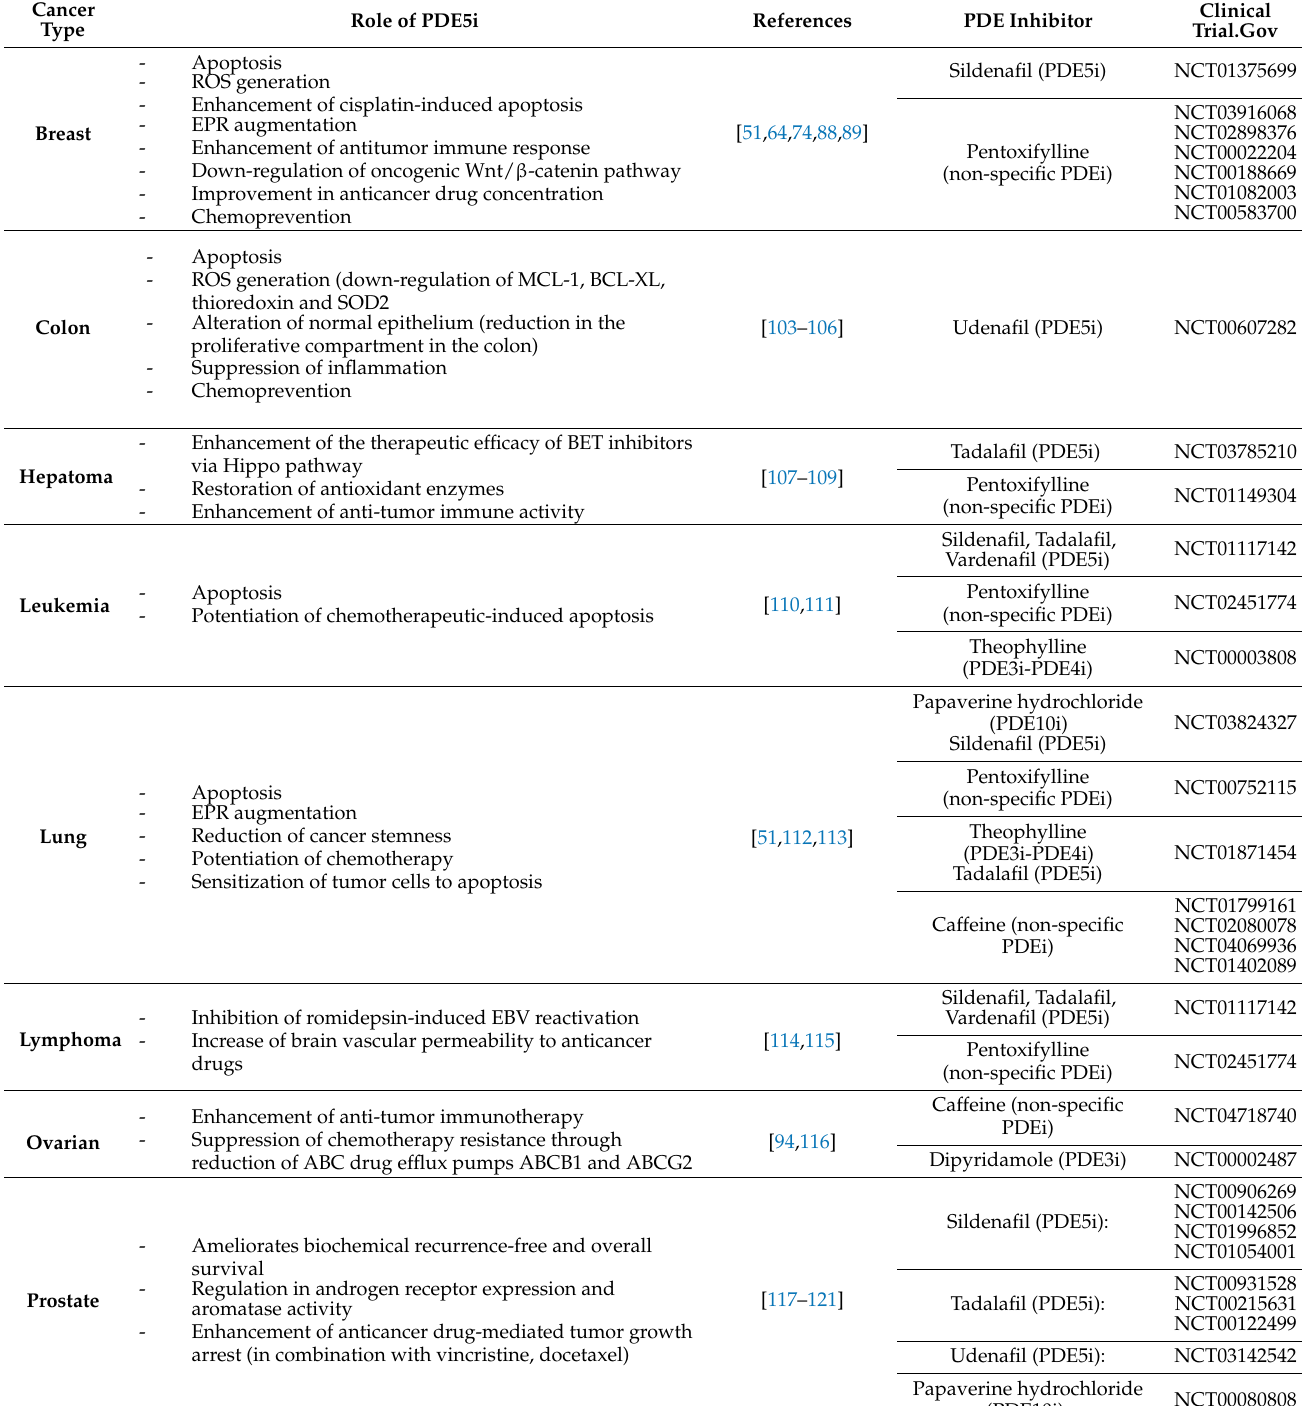
Table 2. Role of PDE5 inhibitors (PDE5i) in several cancer types, and related clinical